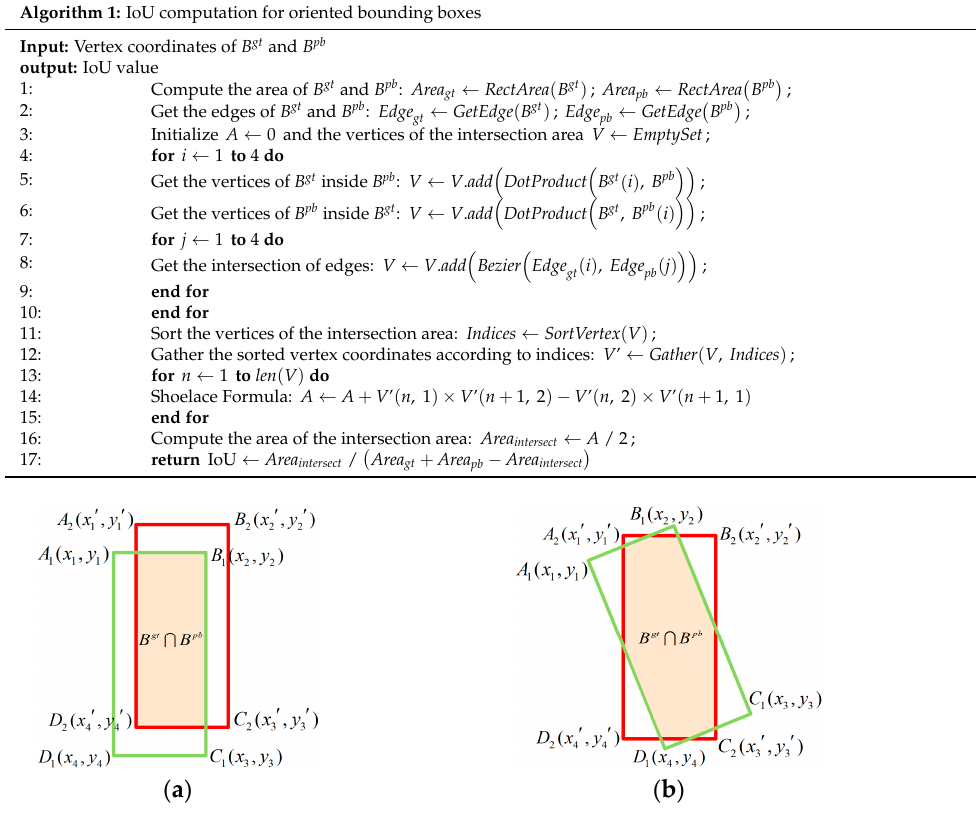
Figure 7. IoU computation for ( a ) horizontal and ( b ) oriented bounding boxes. Red and green boxes represent the predicted box and the ground truth, and the intersection area is highlighted in orange.